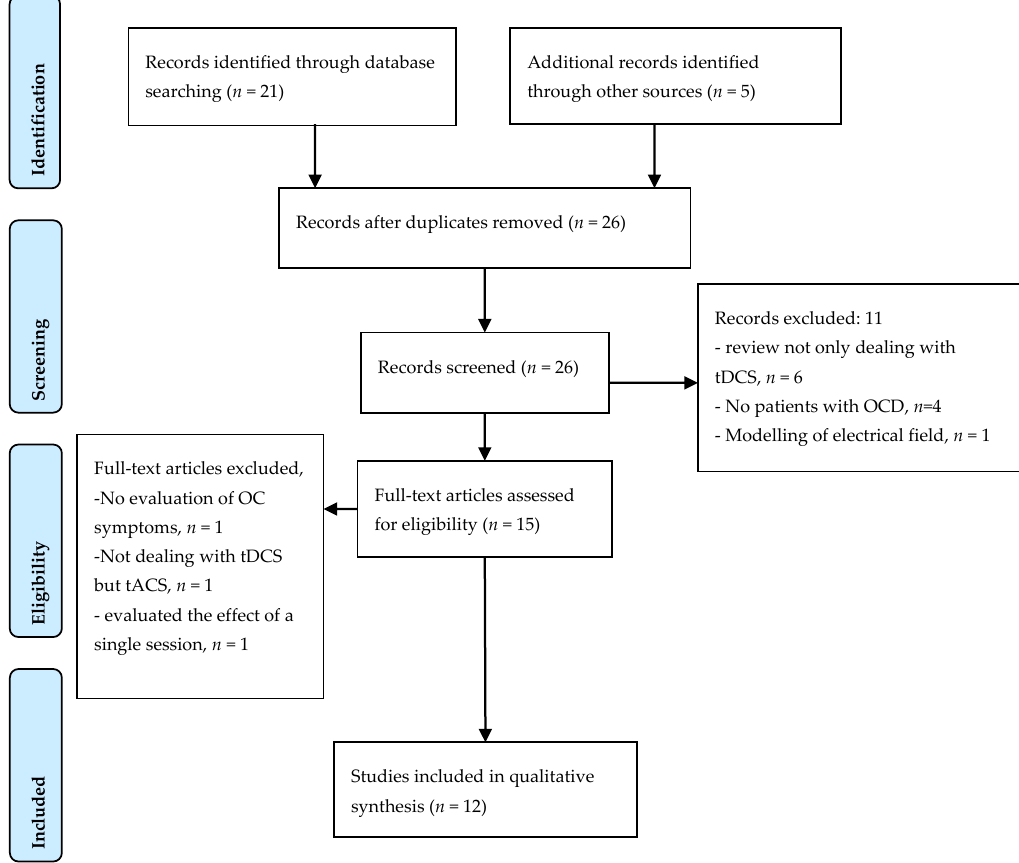
Figure 1. PRISMA flow diagram of selected studies in the qualitative analysis.